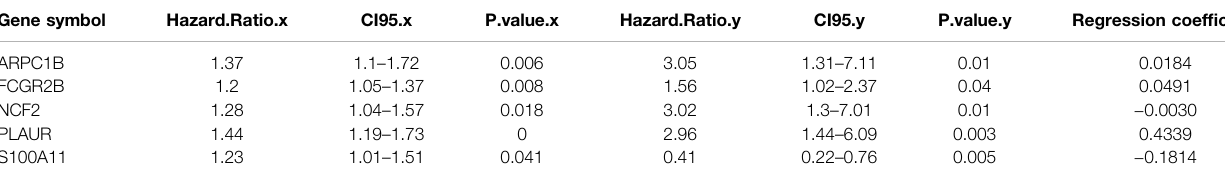
TABLE 1 | Identi fi cation of signature genes and their regression coef fi cients. Gene symbol Hazard.Ratio.x